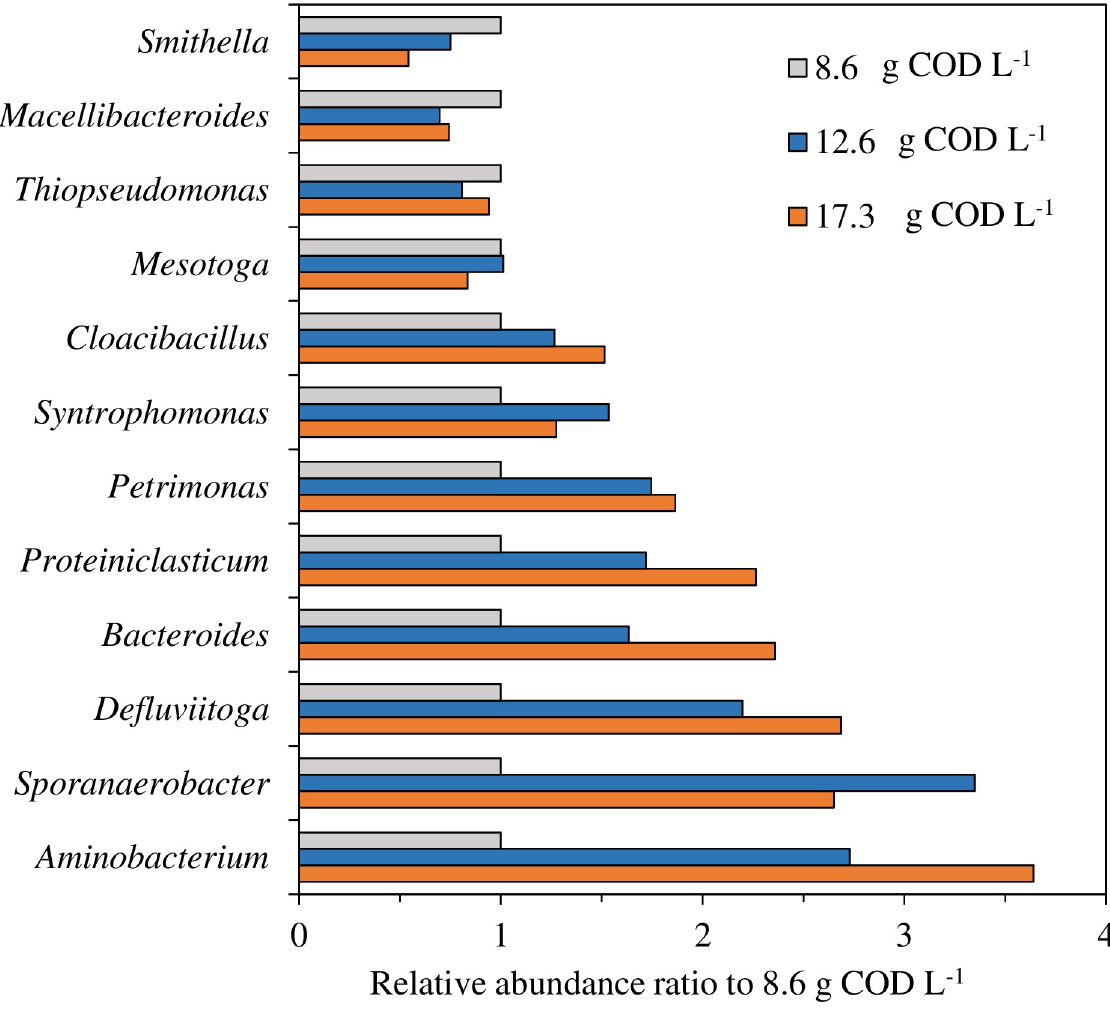
Fig 6. Comparison of the relative abundance among the 12 dominant genera between 8.6 g COD L -1 and 12.6 or 17.3 g COD L -1 scum- loaded vials. https://doi.org/10.1371/journal.pone.0257651.g006 PLOS ONE | https://doi.org/10.1371/journal.pone.0257651 September 30,